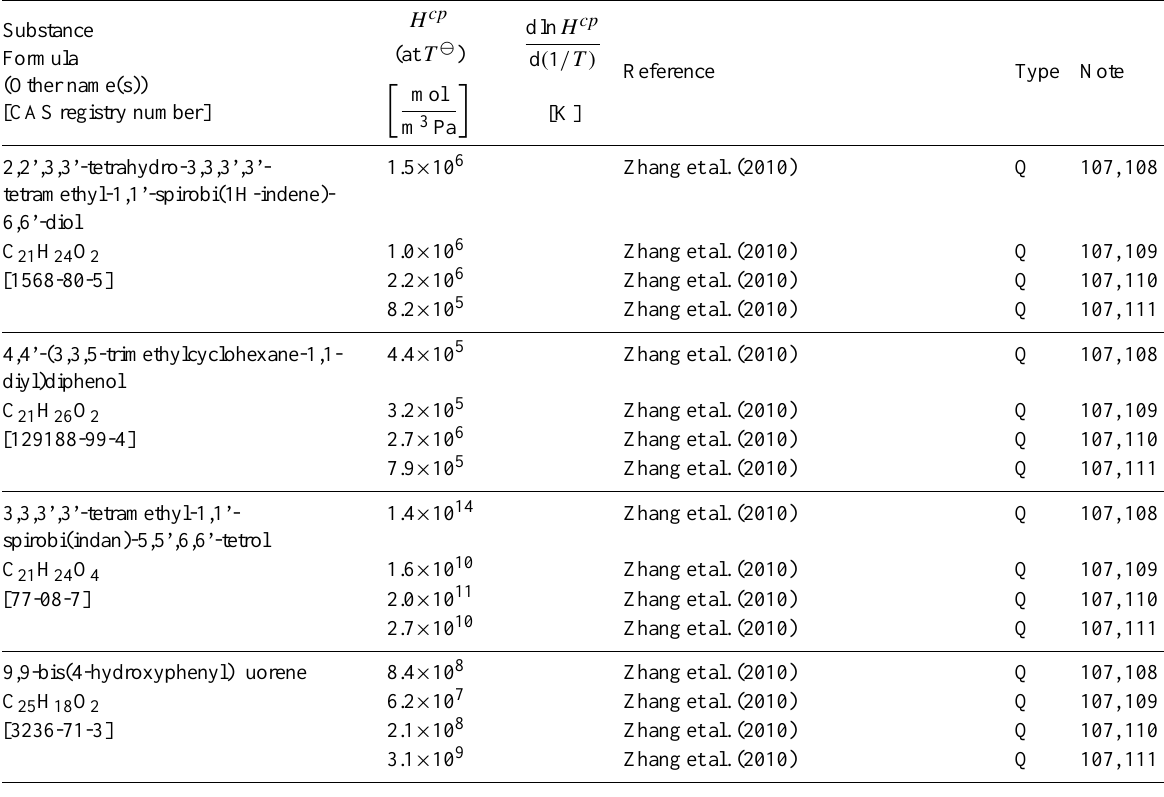
Table 6: Henry’s law constants for water as solvent